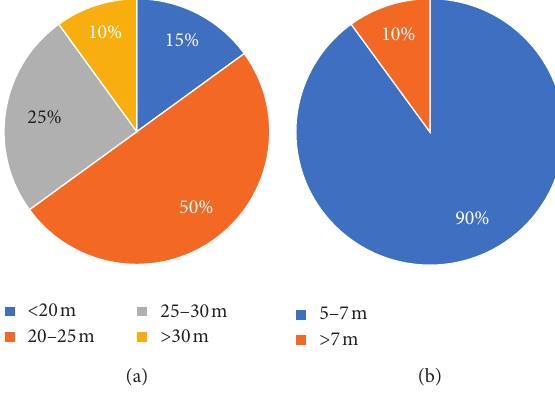
Figure 4: Span length in the (a) longitudinal and (b) transverse directions.